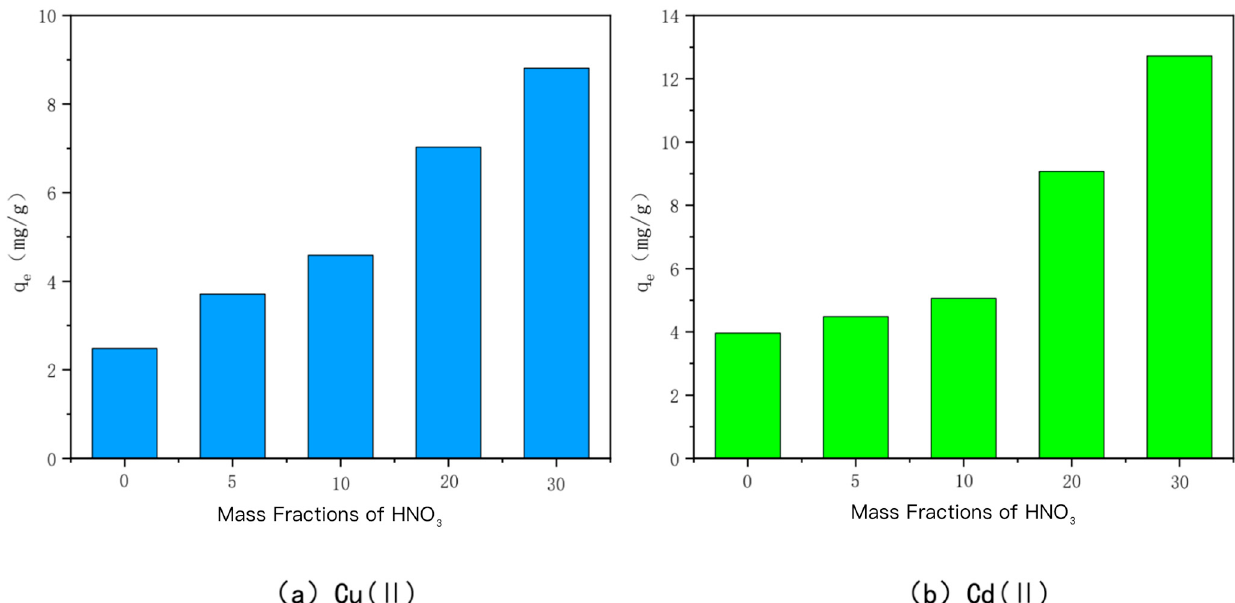
Figure 5. The adsorption capacity of Cu(II)/Cd(II) adsorbed by HNO 3 -modified carbon at different mass fractions of HNO 3 .